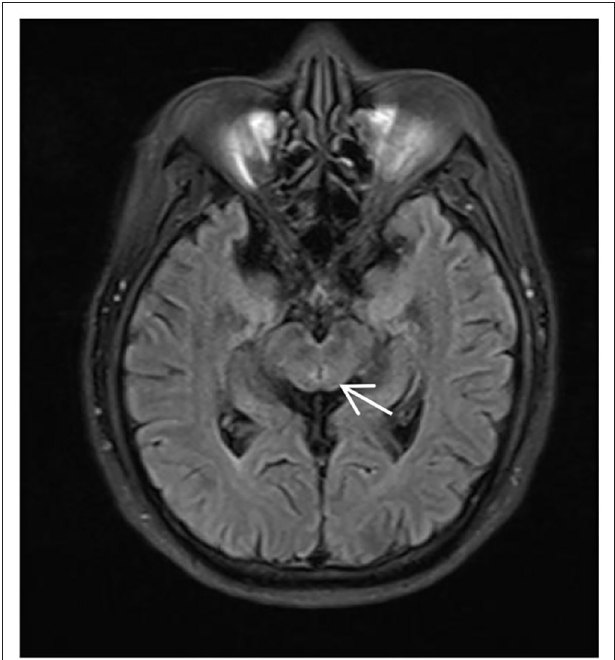
FIGURE 1 | MRI of the patient during his first time in the hospital, T2/fluid-attenuated inversion recovery (FLAIR) showing abnormally high signals around the midbrain aqueduct ( arrow